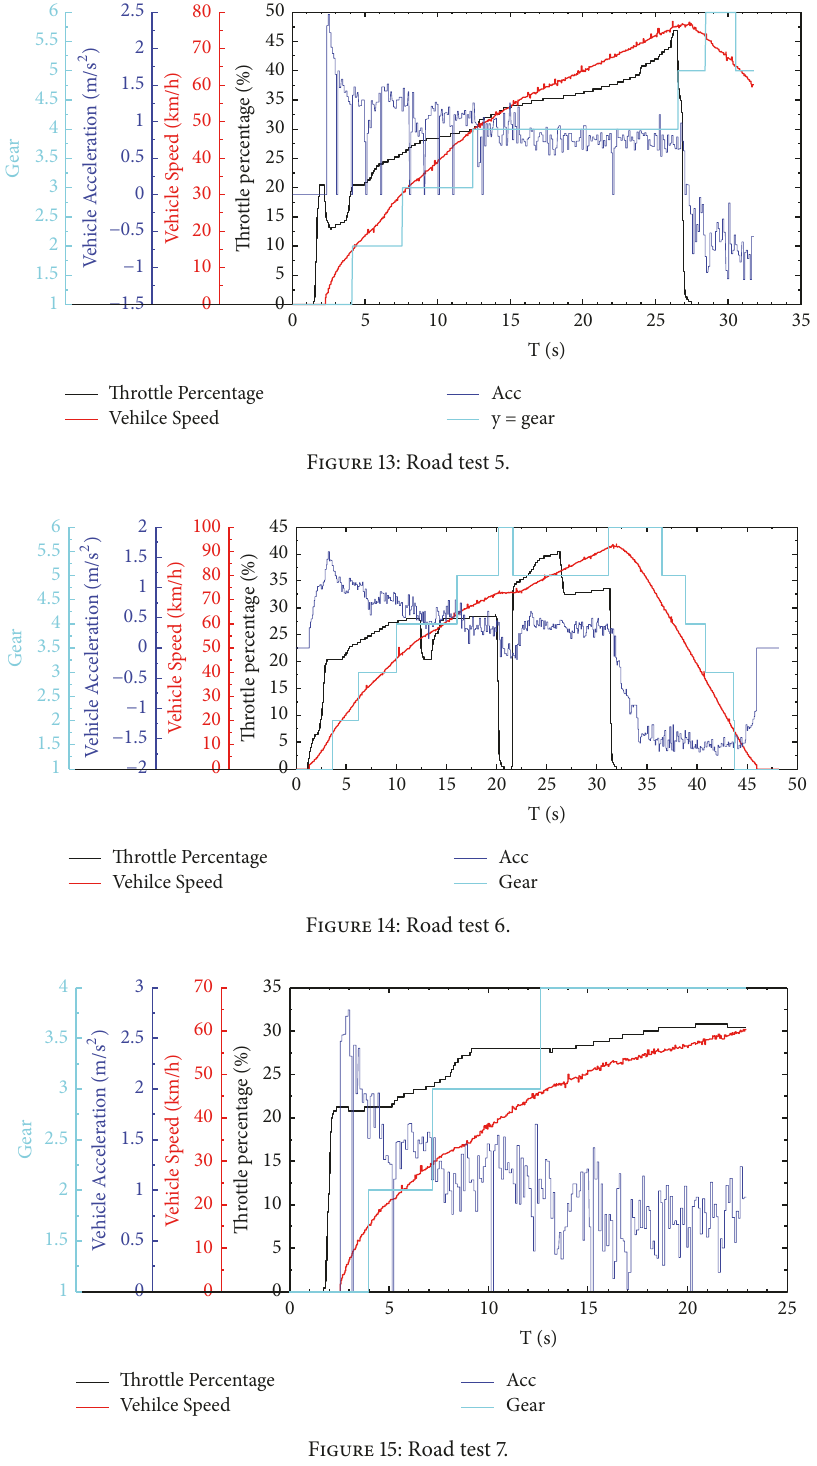
Figure 15: Road test